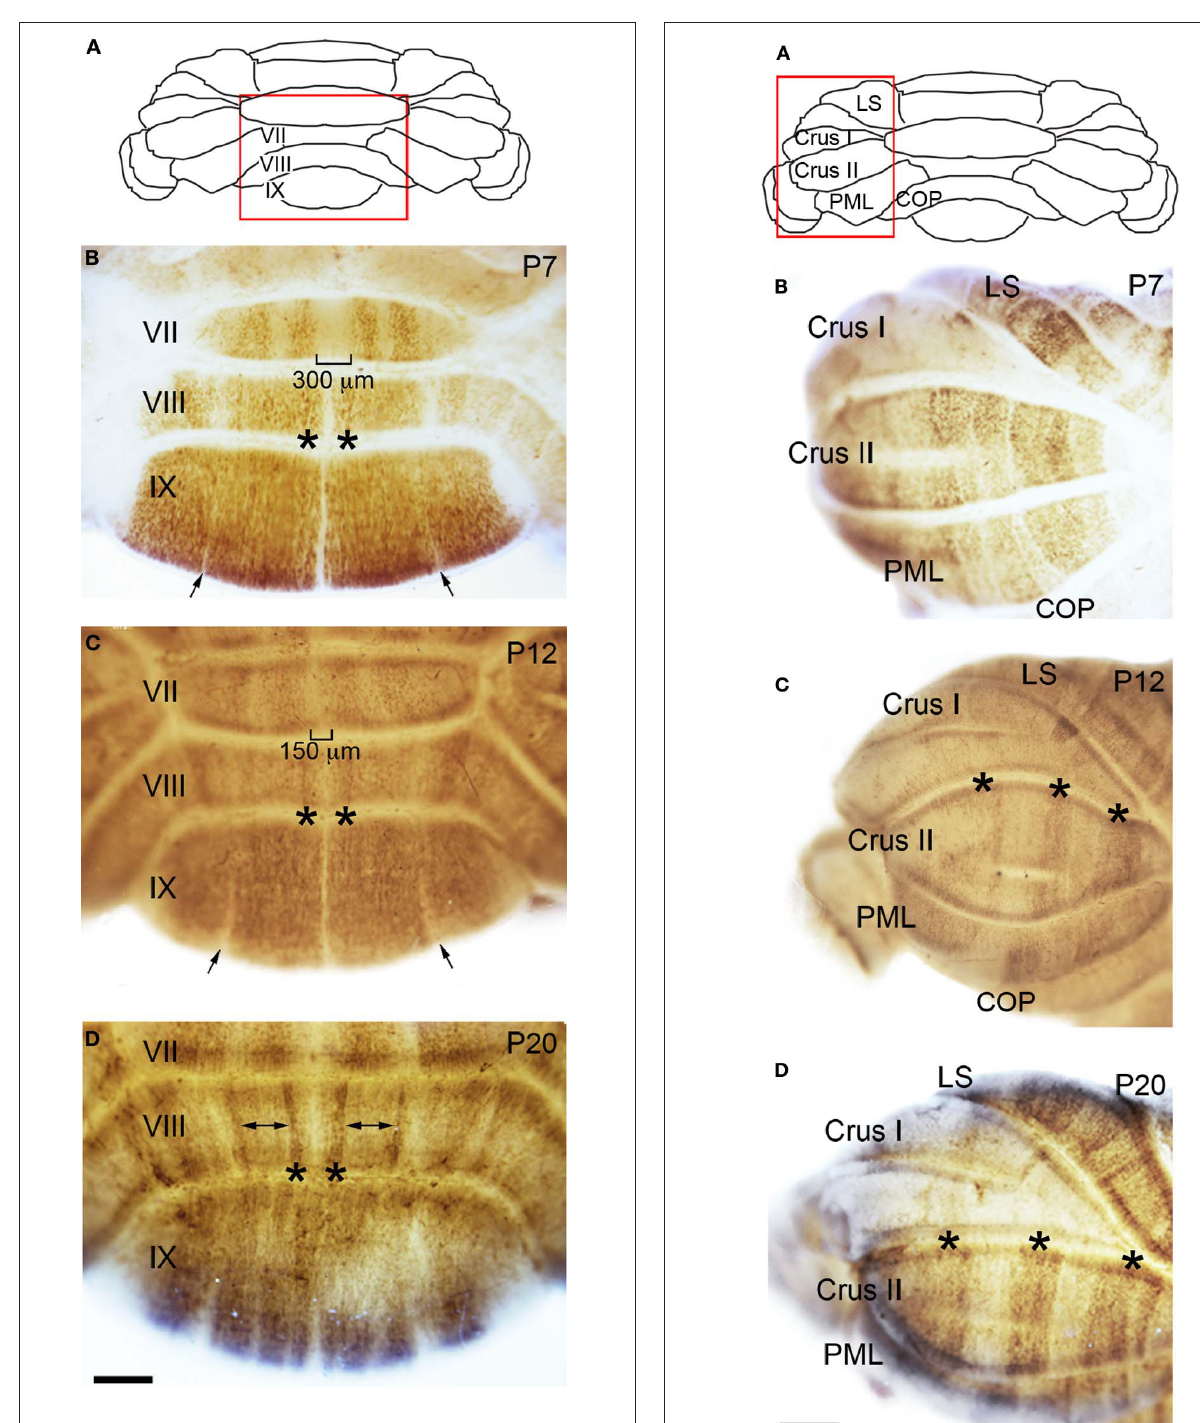
FIGURE 4 | Zone formation in the vermis revealed by NFH expression. (A) Schematic indicating the region of the vermis that is shown in panels (B–D) . (B) At the end of the first postnatal week, NFH expression reveals clear zones in the posterior lobules. (C) By P12, the immunopositive zones in lobule VII have expanded laterally, and immunonegative zones decrease in width accordingly. This expansion is obvious at the midline (brackets). (D) By P20, strong expression at the lateral margins of each zone emerge (asterisks), while weaker expression persists within the center of each zone (double arrows). The negative zones in lobule IX have resolved by P20 (compare to narrow zones marked by arrows in panels B and C ).